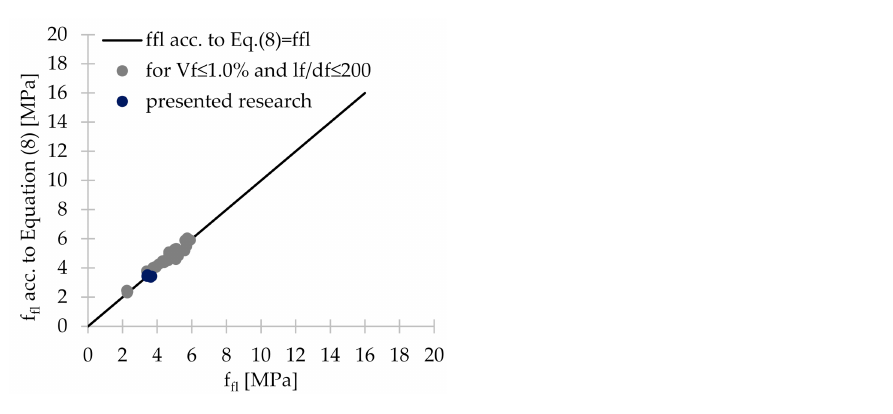
Figure 15. Graphical representation of the correlation of presented research and selected literature positions with the empirical formula for the flexural tensile strength f fl proposed by the